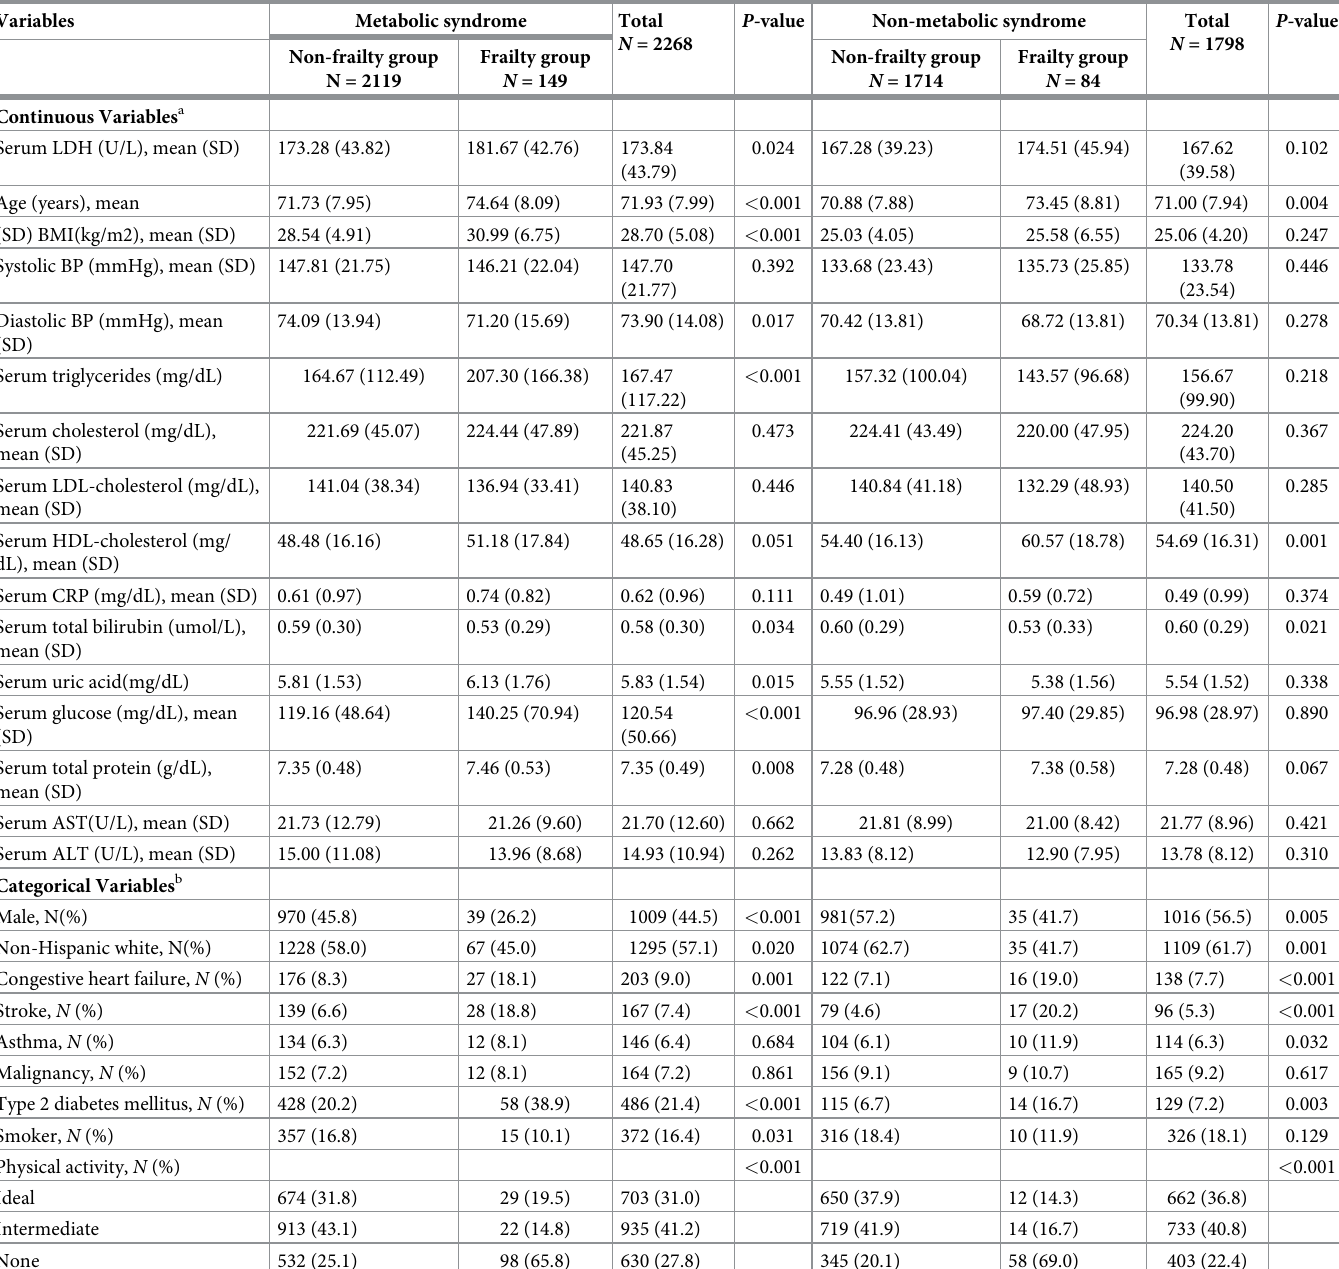
Table 1. Characteristics of the study participants with MetS and non-MetS with and without